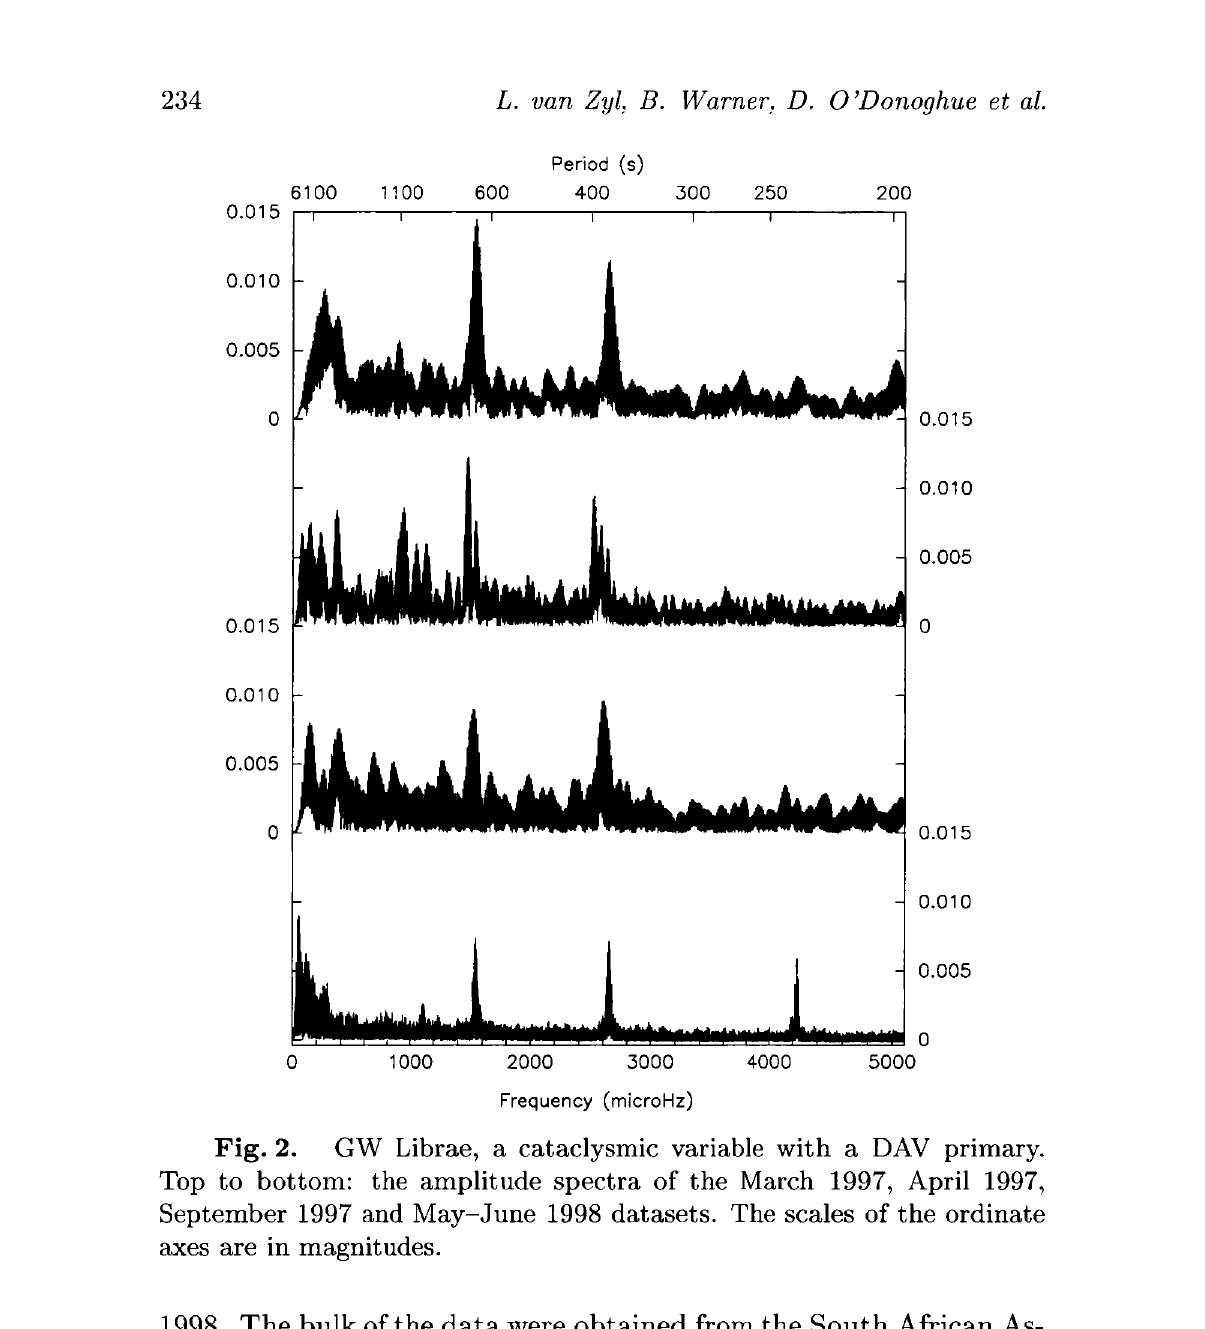
Fig. 2. GW Librae, a cataclysmic variable with a DAV primary. Top to bottom: the amplitude spectra of the March 1997, April 1997, September 1997 and May-June 1998 datasets. The scales of the ordinate axes are in